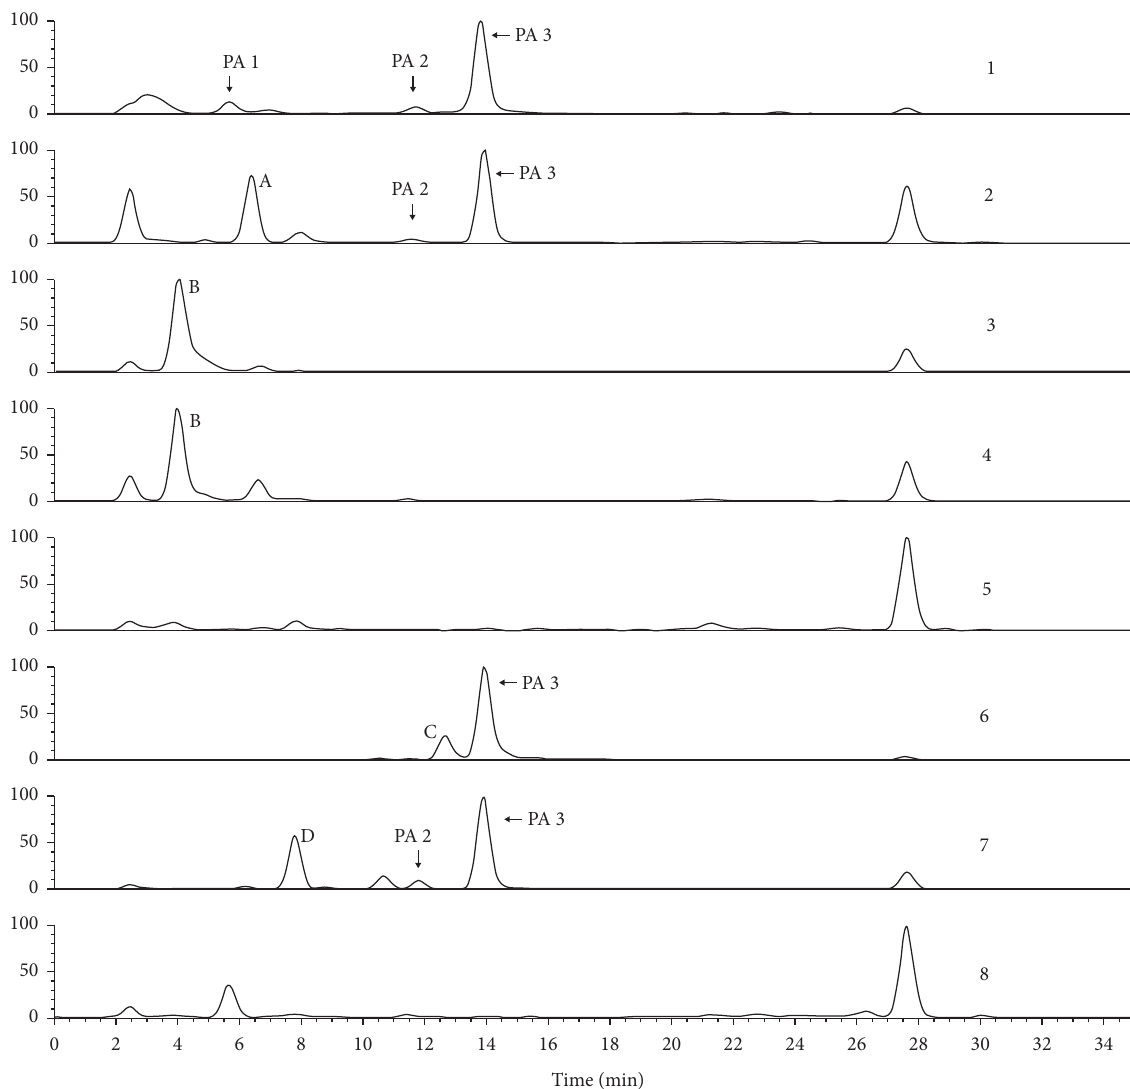
Figure 5: Chromatogram of total MS/MS fragment ion of 366 of eight Senecio plants: 1 , Senecio scandens; 2, Senecio argunensis ; 3, Senecio cannabifolius var . integrifolius ; 4, Senecio cannabifoliu s; 5, Senecio vulgaris ; 6, Tephroseris phaeantha ; 6, Senecio laetus ; and 8, Senecio